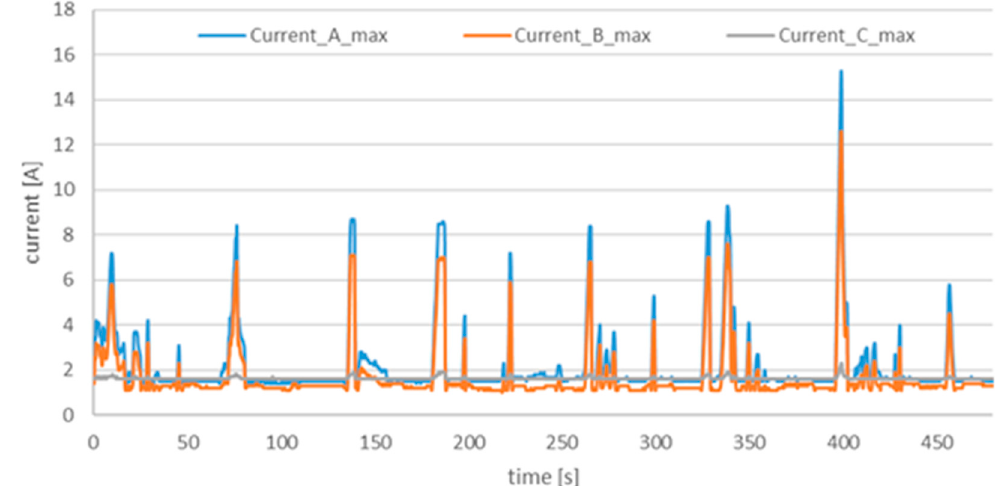
Figure 8. Measured cable screen current; sampling 0.25 s.